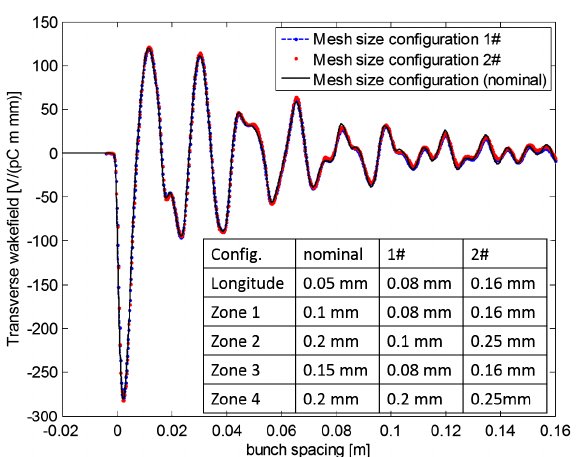
3221.FIG. 12. Configurations of transverse mesh.